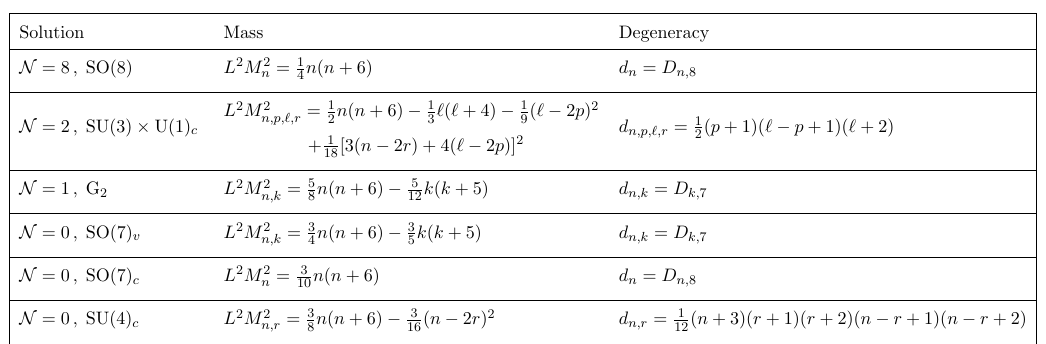
Table 2 . The KK graviton spectra of AdS 4 solutions of D = 11 supergravity that uplift from critical points of D = 4 N = 8 SO(8)-gauged supergravity with at least SU(3) symmetry. See (2.20) for the notation D k;N . The quantum numbers range as in